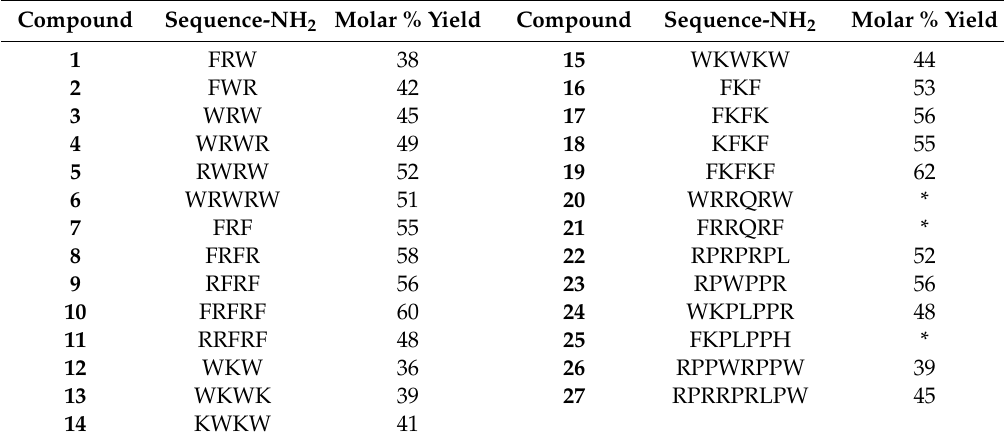
Table 4. Molar percentage